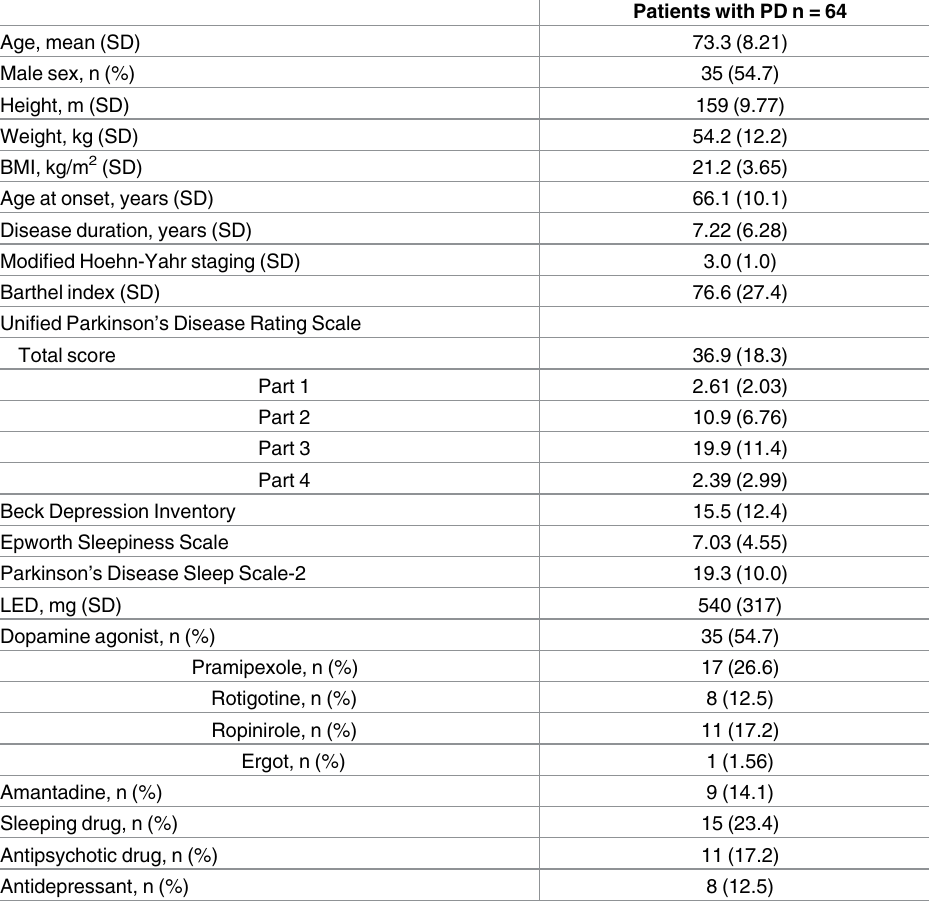
Table 1. Patient